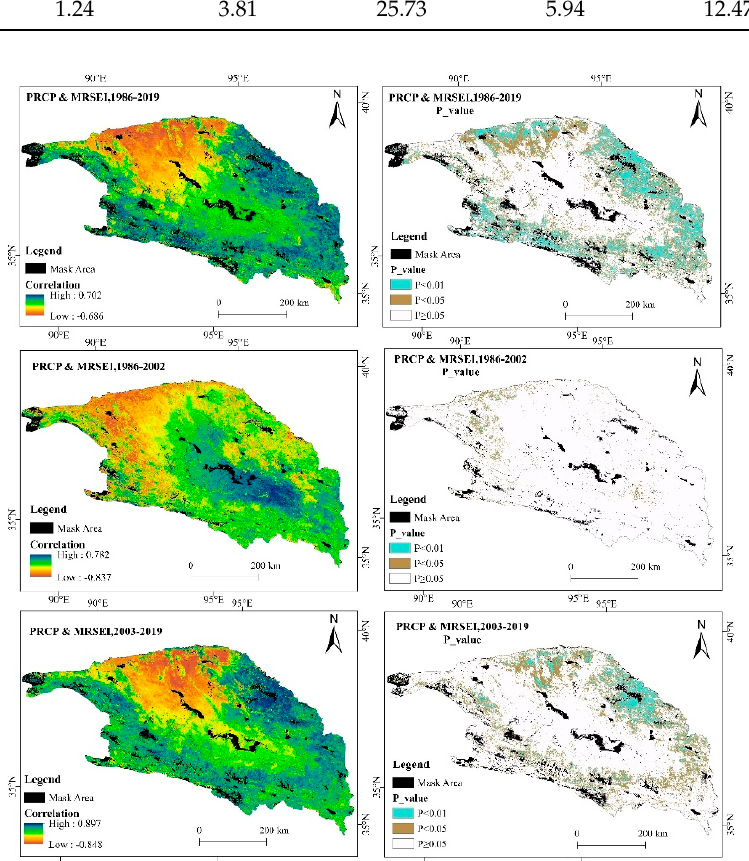
Figure 10. The correlation between MRSEI and precipitation from 1986 to 2019.